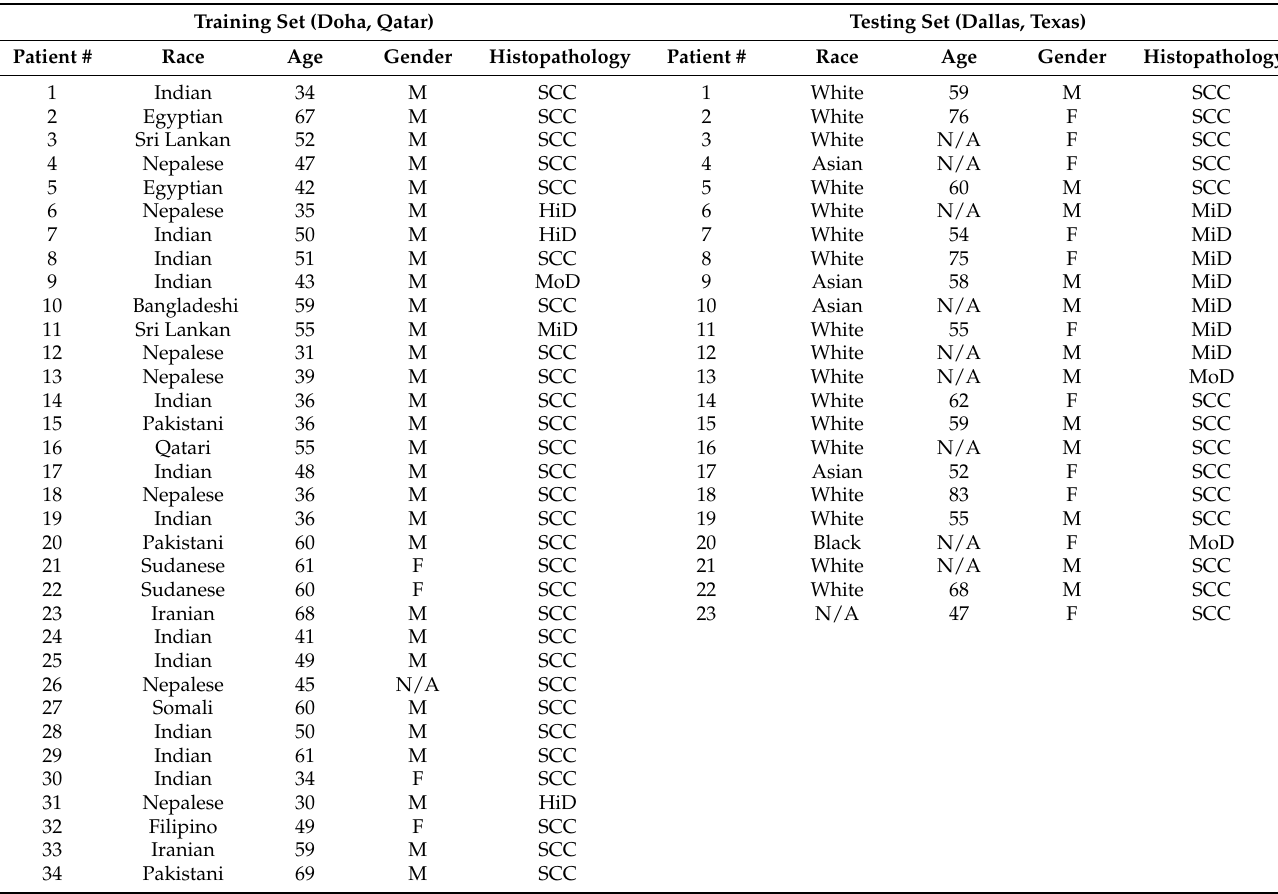
Table 2. Demographics of the two patient populations included in this study (MiD: Mild Dysplasia; MoD: Moderate Dysplasia; HiD: High-Grade Dysplasia; SCC: Squamous Cell